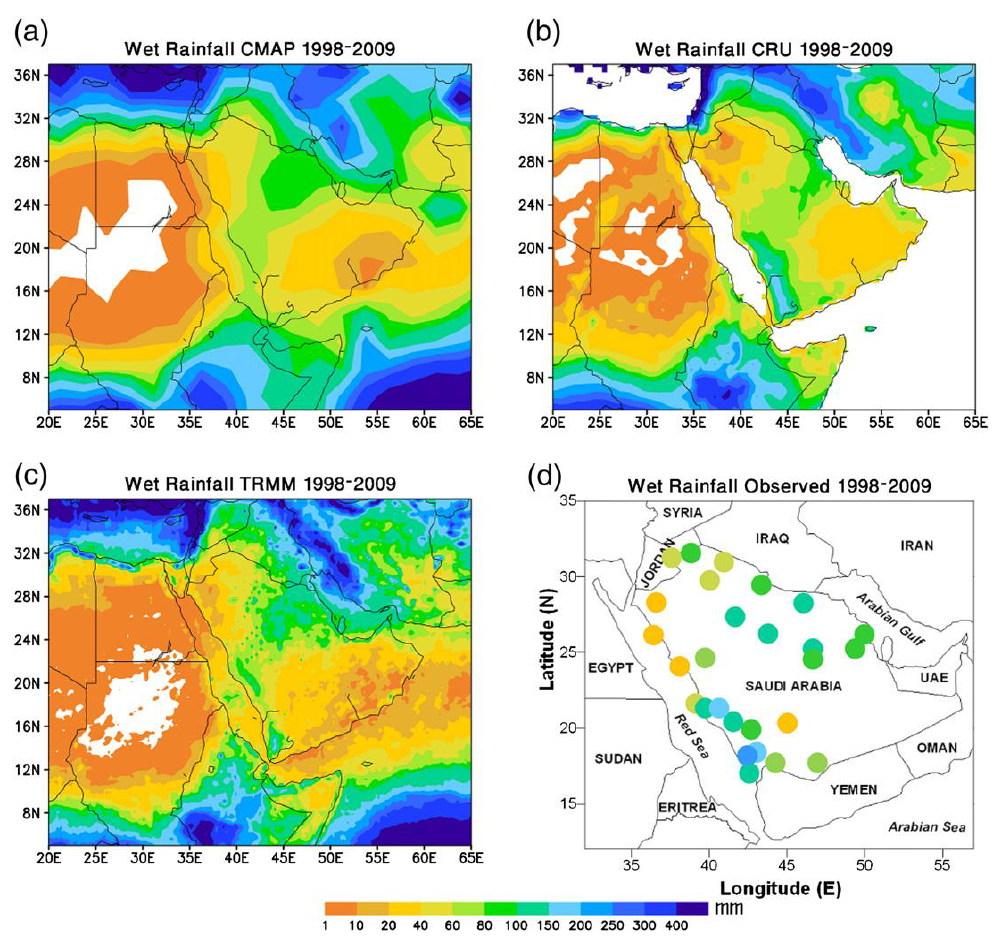
Figure 4. Spatial distribution of the wet season rainfall (mm) averaged over the period 1998–2009 obtained from the ( a ) CMAP; ( b ) CRU; ( c ) TRMM; and ( d ) station datasets